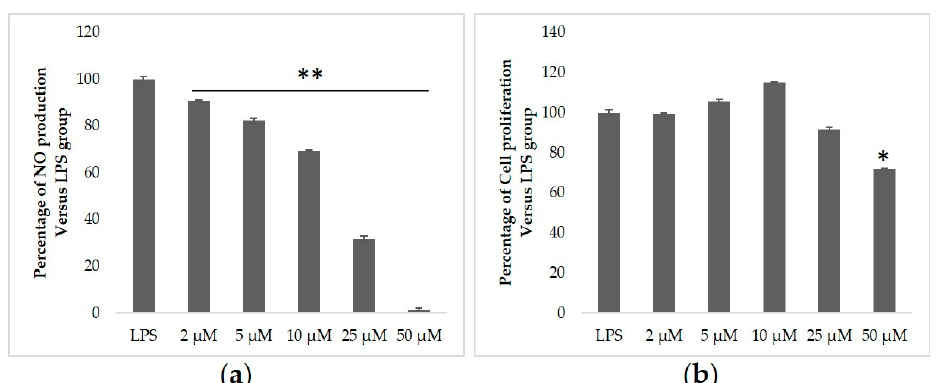
Figure 2. Effects of heliangin from Jerusalem artichoke leaves in RAW 264.7 cells stimulated with LPS. ( a ) Inhibition of NO production. ( b ) Cell proliferation. Values are shown as the mean ± SD ( n = 4); * p < 0.01 and ** p < 0.001 vs. LPS (ANOVA with post hoc Dunnett tests). Table 2. The 1 H ‐ NMR and 13 C ‐ NMR chemical shifts of fraction 6 ( δ in ppm).